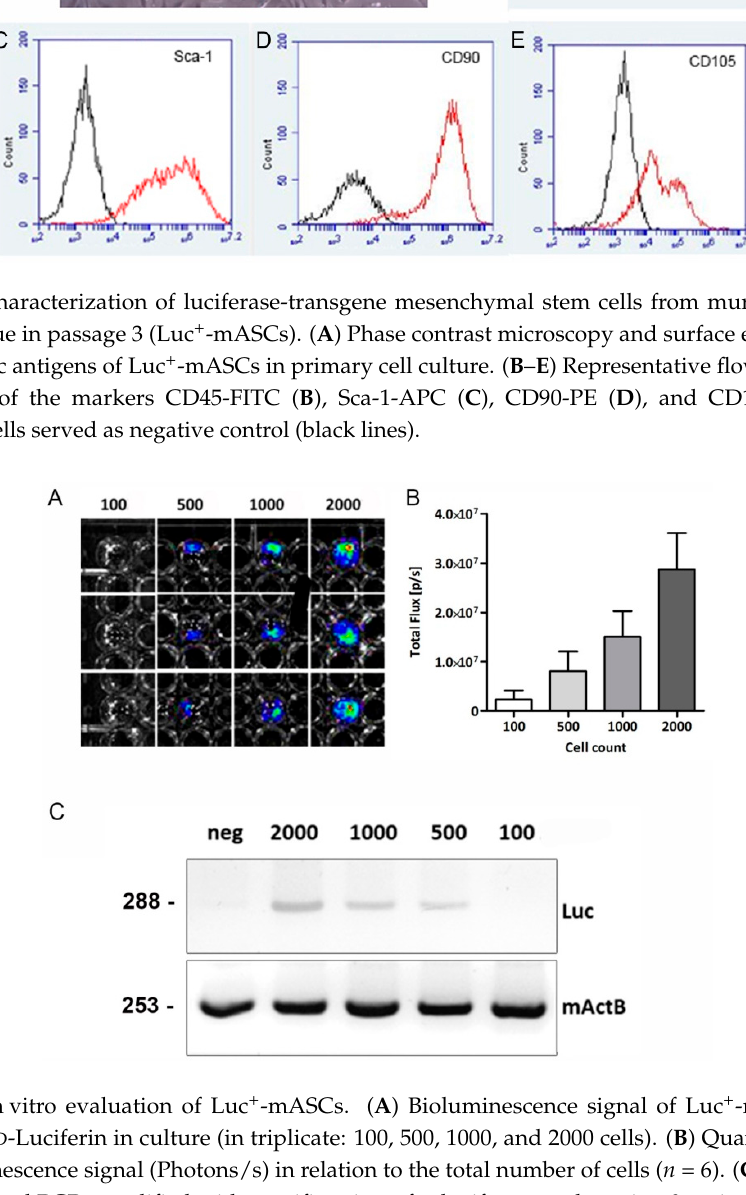
Figure 3. Effect of cisplatin injection on serum N-GAL ( A ) and creatinine ( B ) levels. Mice were injected with 8 mg/kg and 12 mg/kg cisplatin i .p . and serum levels of N-GAL and creatinine were measured on day 6. Data are expressed as ng/mL (N-GAL) and mg/mL (creatinine) (mean ± SEM); * p < 0.05 and ** p < 0.01 vs. control; n = 5 per group.